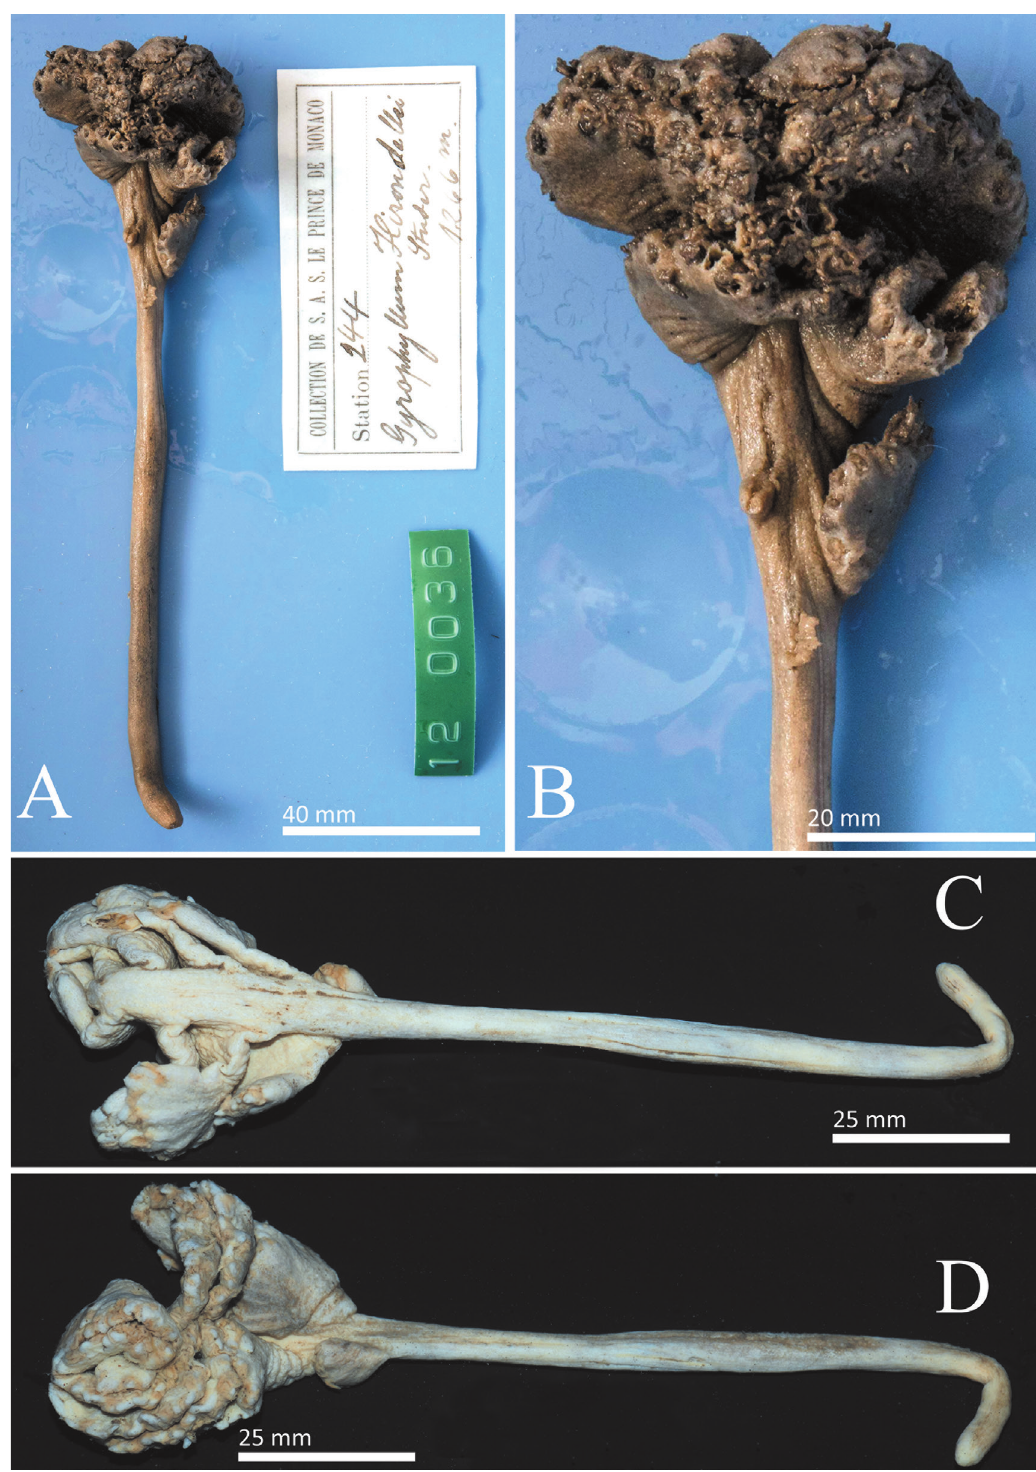
Fig. 4. Gyrophyllum hirondellei Studer, 1891. A . Holotype colony of G. hirondellei (MOM INV 120036) deposited in the Musée oceanographique de Monaco, ventral view. B . Detail from A, showing the compacted group of polyp leaves and autozooids ‘calyces’ without evident pointed processes. C–D . Dorsal and ventral view of BIAÇORES colony (MNHM OCT.A.579), see also Fig. 6A–B. Photographs A–B: Michel